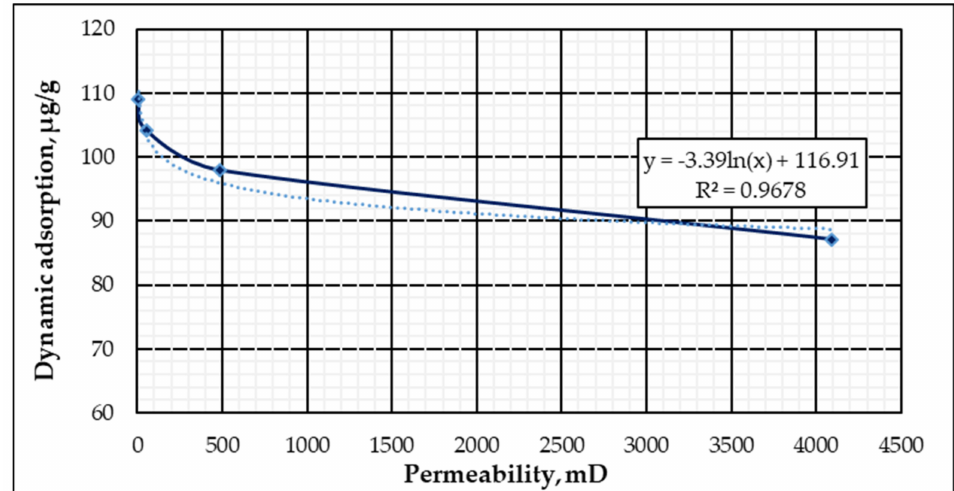
Figure 12. Diagram of adsorption indicator dependency on core model